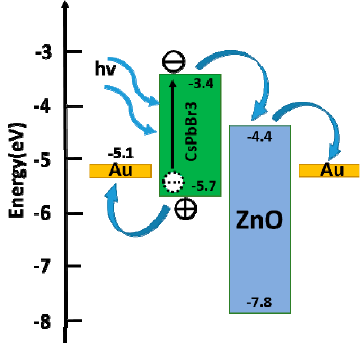
Figure 6. Schematic illustration of the energy level of the complete phototransistor.